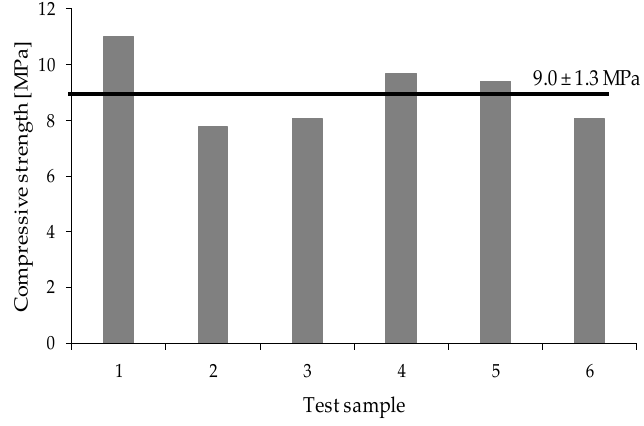
Figure 10. Compressive strength results.